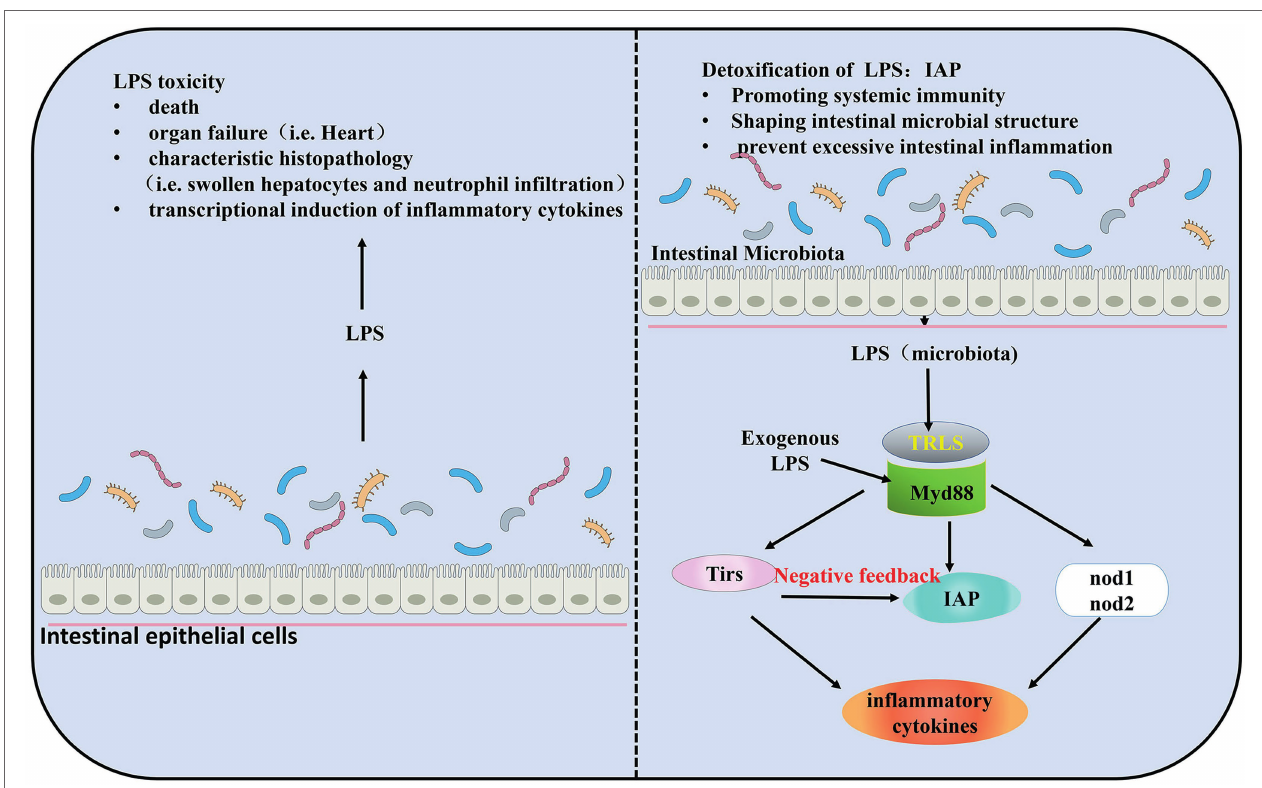
FIGURE 1 | Intestinal homeostasis during the establishment of gut microbiota colonization by Myd88, toll like receptors (TLRs). Lipopolysaccharide (LPS) is required for the induction of intestinal alkaline phosphatase (IAP) activity and triggers intestinal inflammation through TLRs and Tnf signaling. IAP transcript levels were significantly elevated in the presence of gut microbiota. Exposure to exogenous LPS increases IAP transcript levels in germ-free (GF) larval zebrafish and results in higher than normal IAP levels in conventionally reared (CV) larval zebrafish. In a negative feedback loop formed by TLRs, IAP, and LPS, IAP dephosphorylates LPS, and TLRs and Tnf are reduced by LPS dephosphorylation, thereby preventing excessive intestinal